Question: Sum up the contents of this chart in one sentence.
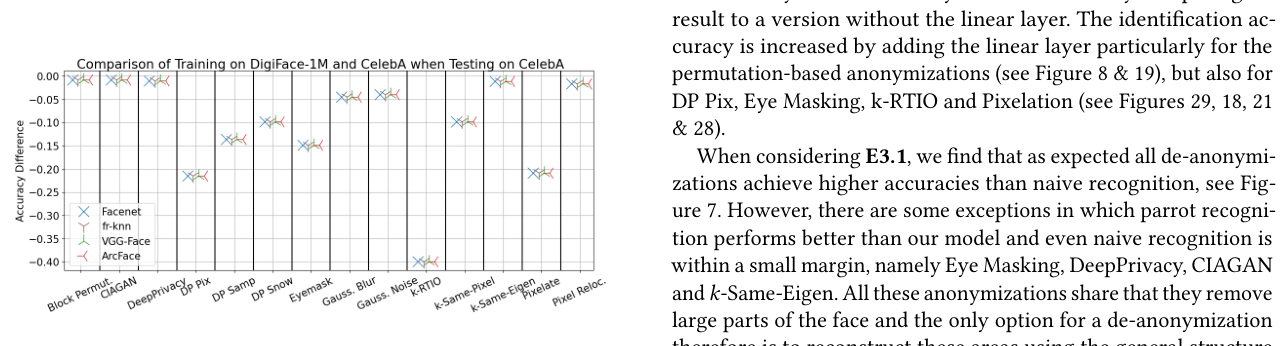
Answer: Difference in recognition accuracy when our model is trained on DigiFace-1M instead of CelebA for all anonymi- zations; tested on 300 identities of CelebA.